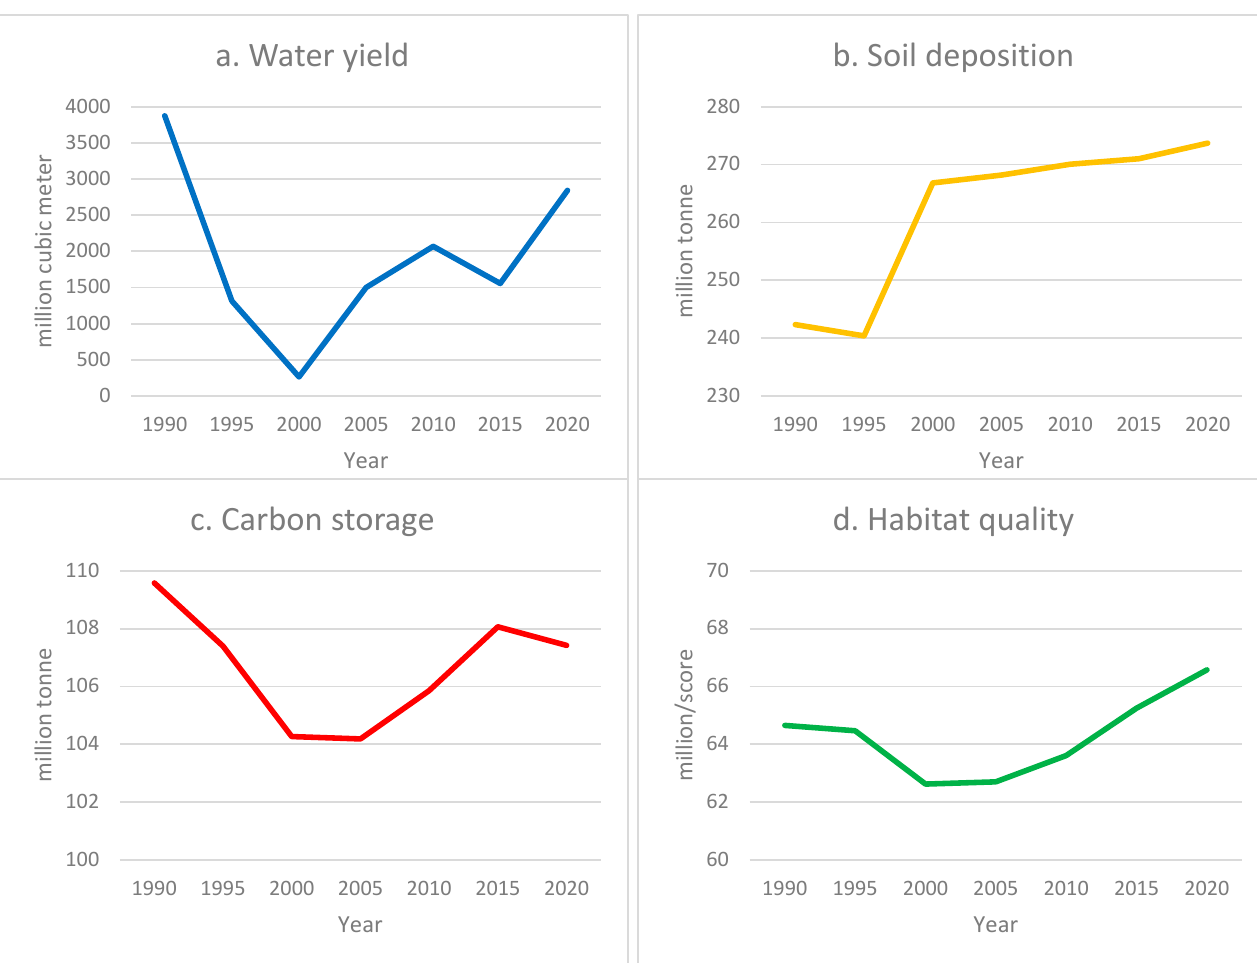
Figure 4. Temporal changes in ( a ) Water yield, ( b ) Soil deposition, ( c ) Carbon storage, and ( d ) Habitat quality from 1990 to 2020. Table 4. Temporal changes of water retention, soil conservation, carbon sequestration, and habitat improvement in six